Question: What visual encoding does this figure use to show its data?
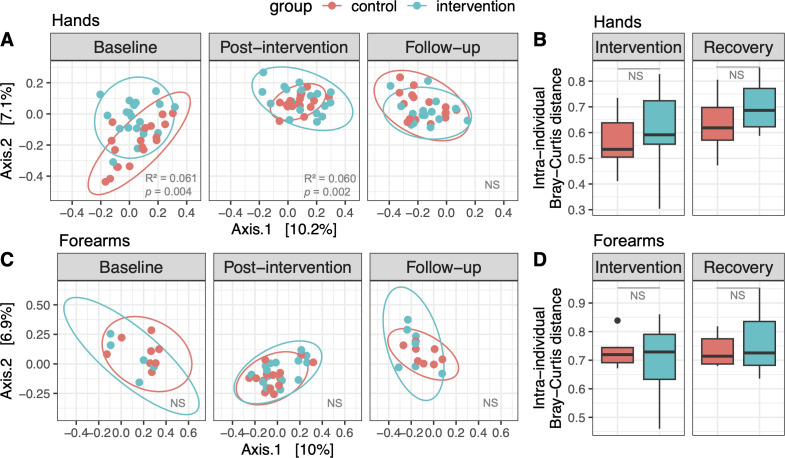
Answer: box